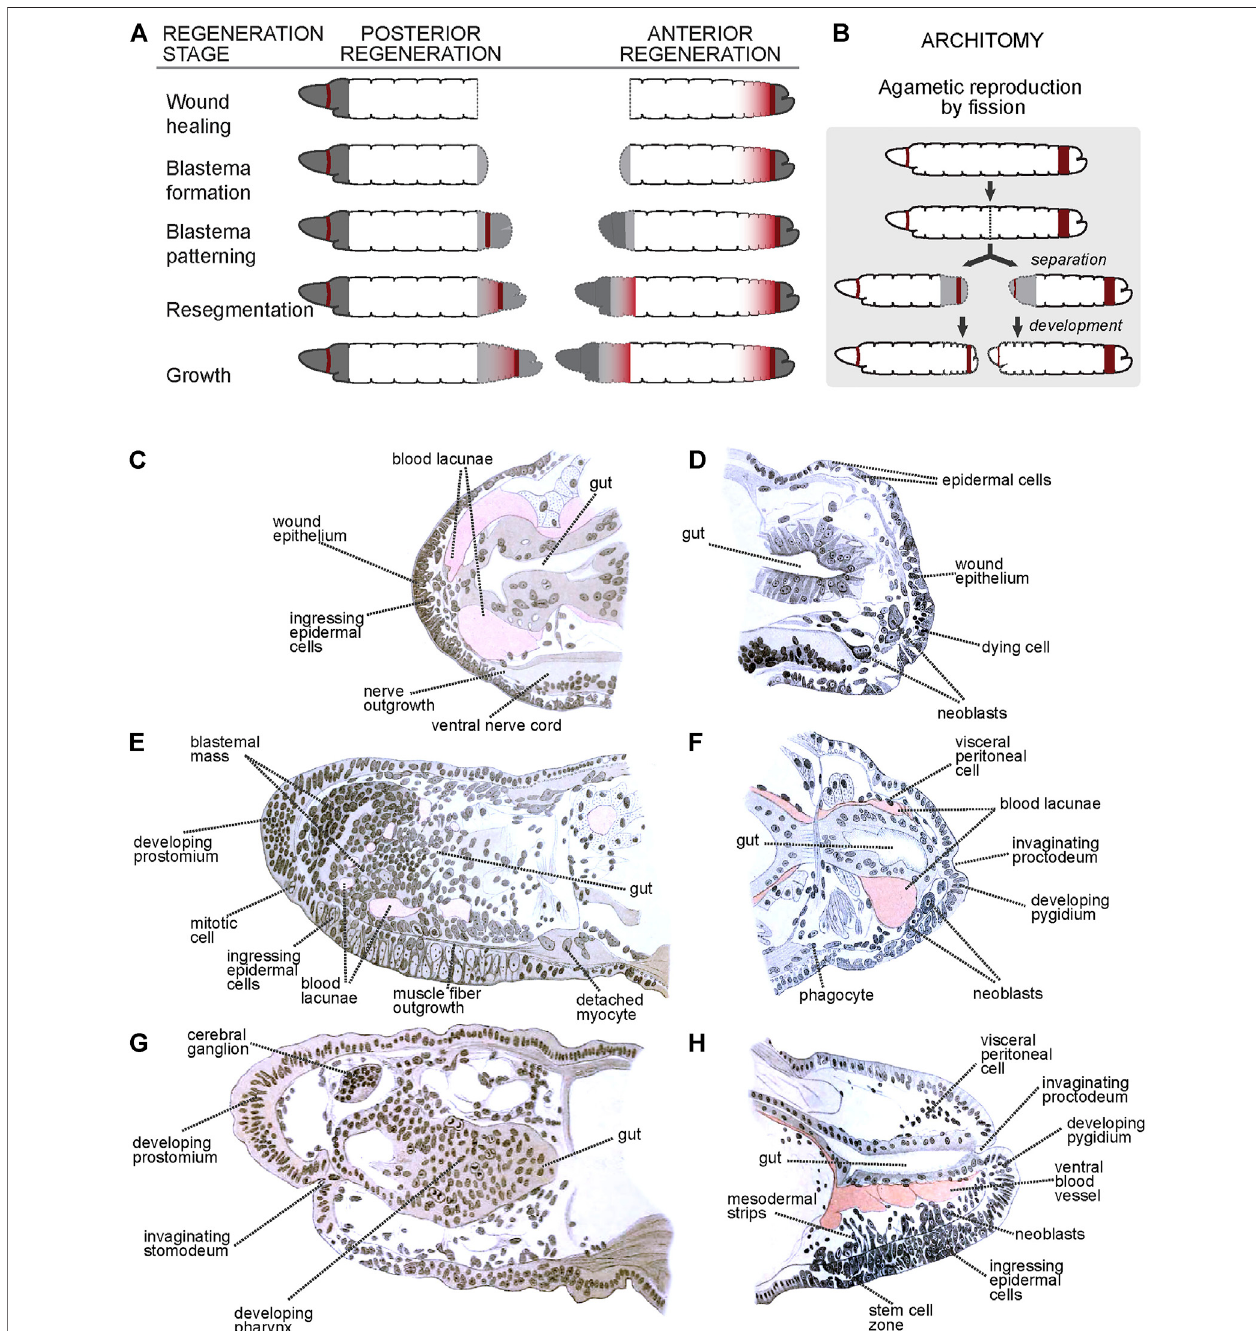
FIGURE 1 | Regeneration and asexual reproduction in Lumbriculus . (A) Generic stages of annelid regeneration. Dashed line: cut/regenerated tissue; dark gray: non-segmental tissues; dark red: mitotically active areas; gray shading: differentiating segmental tissues. (B) Asexual reproduction by fi ssion. Coloring as in A. (C – H) Histologicalsectionsthroughearly (C) ,middle (E) andlate (G) anteriorlyregeneratingindividuals,andearly (D) ,middle (F) andlate (H) posteriorlyregeneratingindividuals. (C – H) After Iwanow (1903); all labels are direct or interpreted translations of the original German labels.